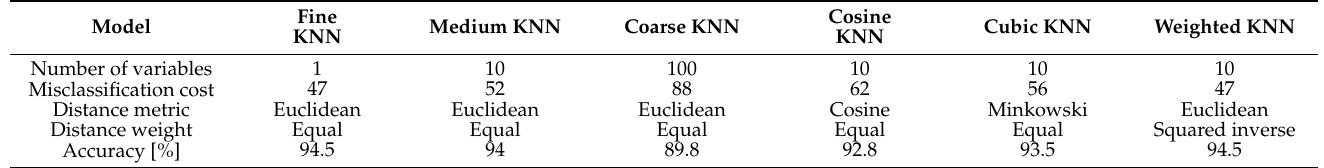
Table 4. Pump state classification models and their main